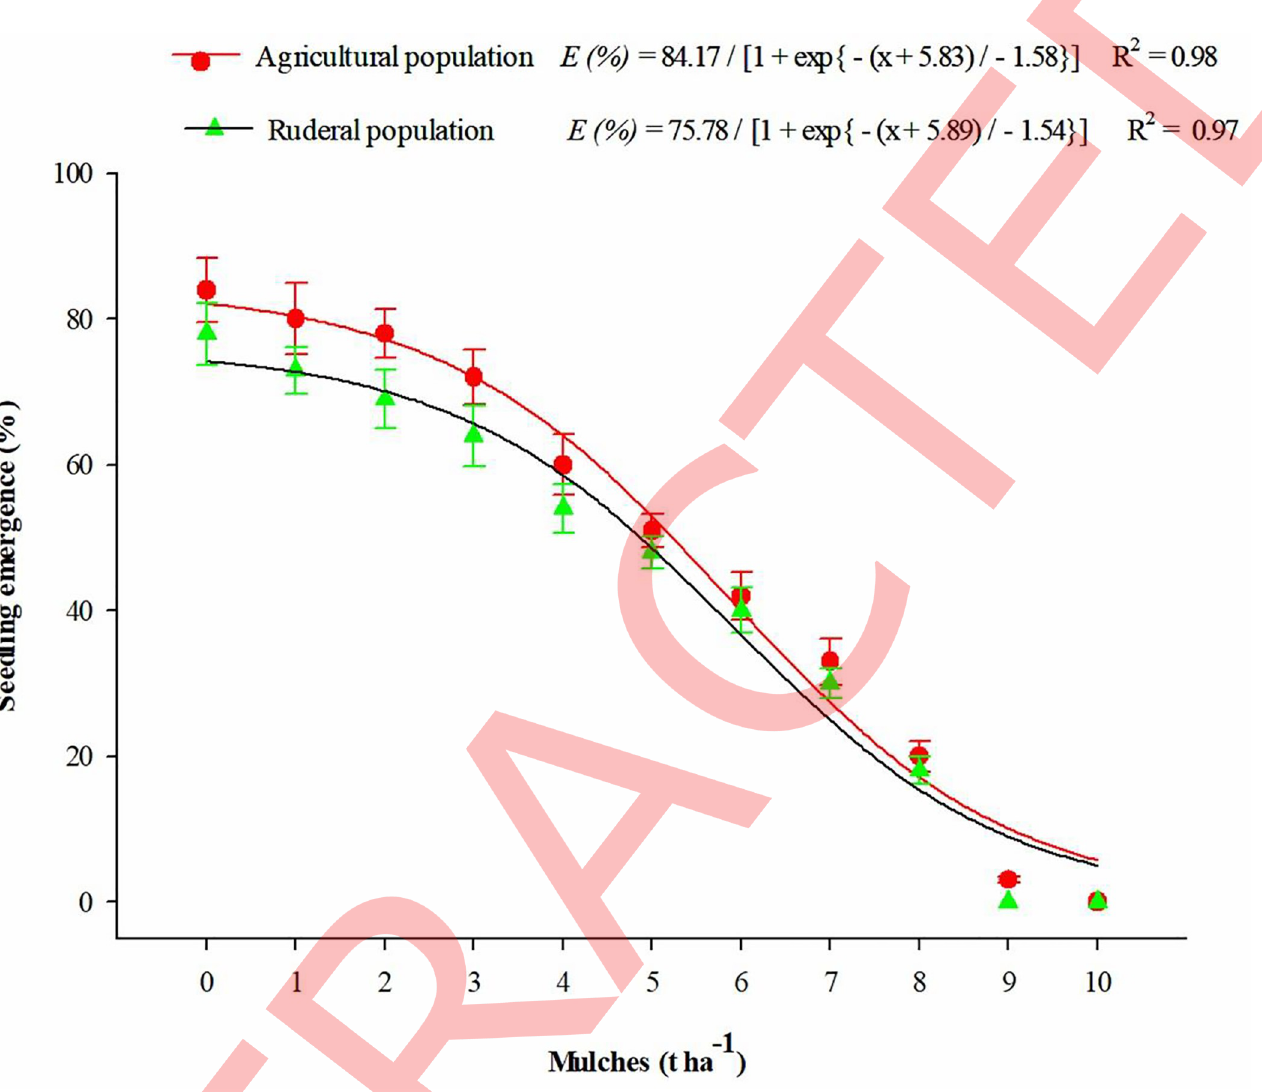
Fig 7. The influence of different sorghum mulch doses on seedling emergence percentage of ruderal and agricultural populations of Xanthium strumarium